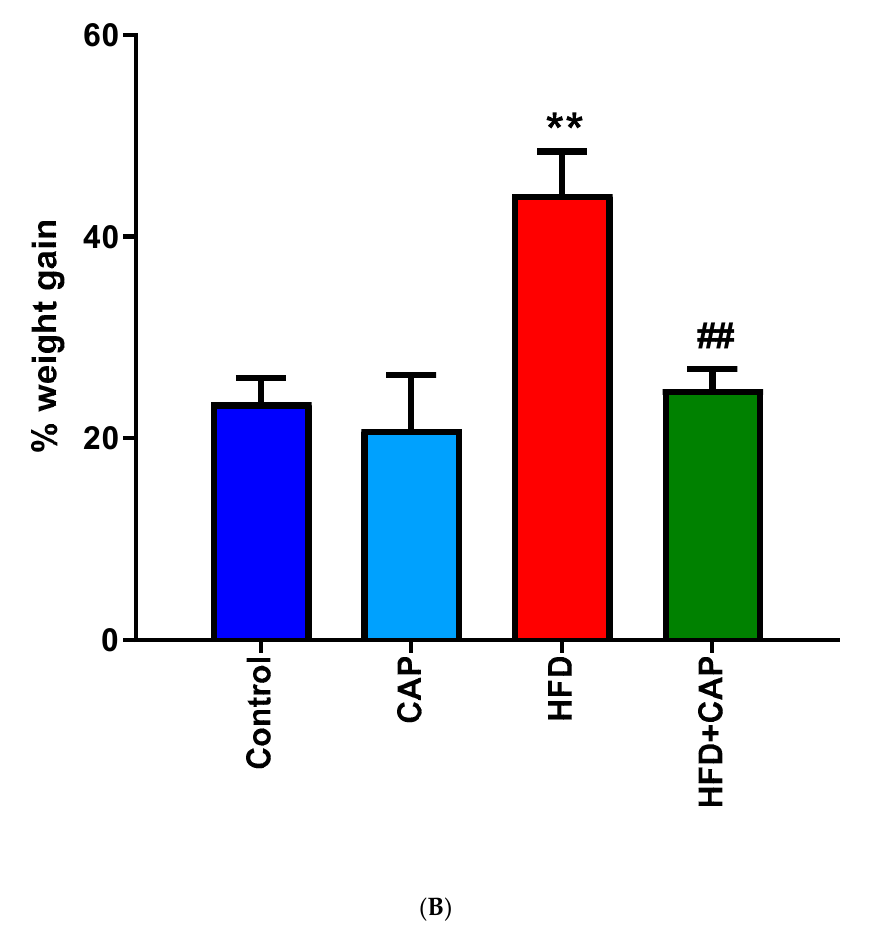
Figure 1. In C57BL/6 mice, capsaicin (2 mg/kg/day, per os ) reduced weight gain by approximately 50% in animals that were kept on HFD ( A , B ), but had no effect on body weight in the normal chow group ( B ). Figure courtesy of Dr. Mahendra Bishnoi (based on [12]). ** p < 0.01 versus control animals, ## p < 0.01 versus HFD animals.